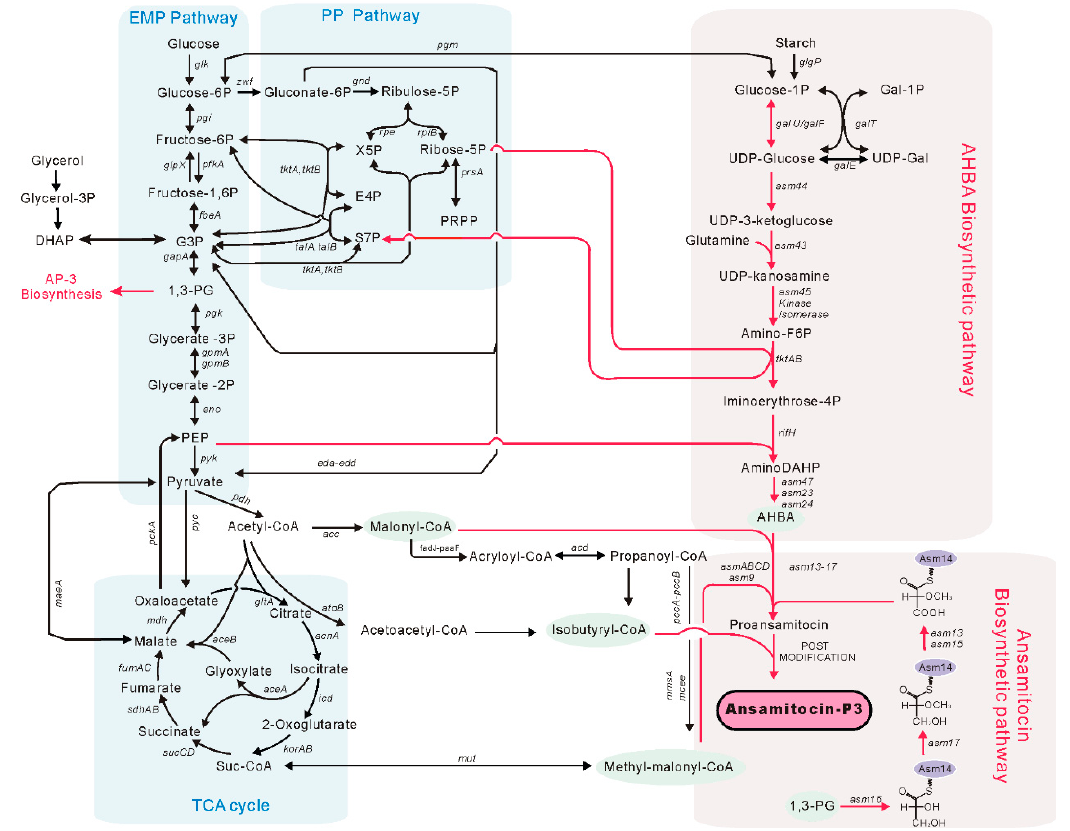
Figure 1. Biosynthetic pathway of ansamitocin P-3 in Actinosynnema pretiosum . AP-3: ansamitocin P-3; EMP pathway: Embden Meyerhof Parnas pathway; PP pathway: pentose phosphate pathway; G3P: glyceraldehyde 3-phosphate; PEP: phosphoenolpyruvate; DHAP: dihydroxyacetone phosphate; X5P: D-xylulose 5-phosphate; UDP: uridine diphosphate; Gal: alpha- D -Galactose; E4P: erythrose 4-phosphate; S7P: sedoheptulose 7-phosphate; PRPP: 5-phosphoribosyl 1-pyrophosphate; AHBA: 3- amino-5-hydroxybenzoic acid; F6P: fructose-6-phosphate; TCA cycle: tricarboxylic acid cycle.